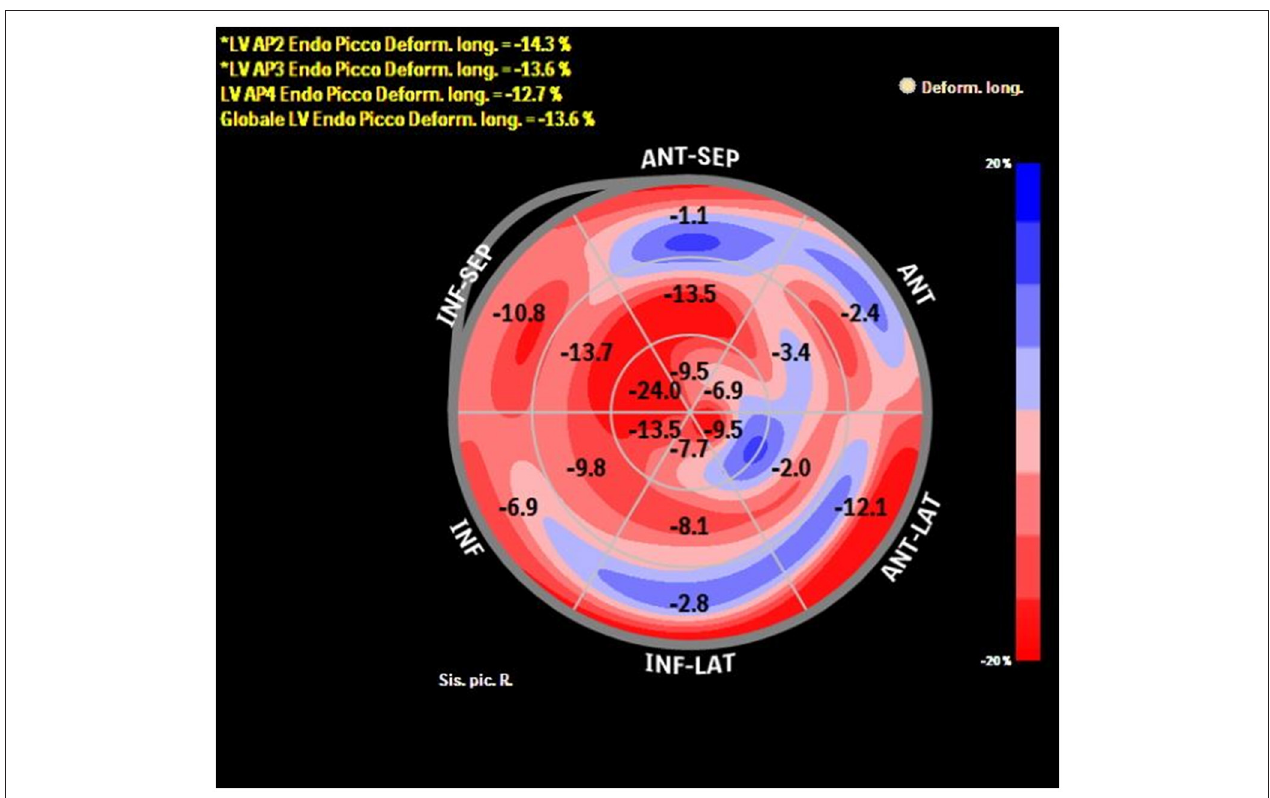
FIGURE 1 | Bull-eye depicting longitudinal strain of the LV by speckle tracking echocardiography in a patient with previous TTS at 1-month follow-up after the acute event. Despite complete recovery of LVEF, longitudinal systolic function is still impaired (global longitudinal strain −